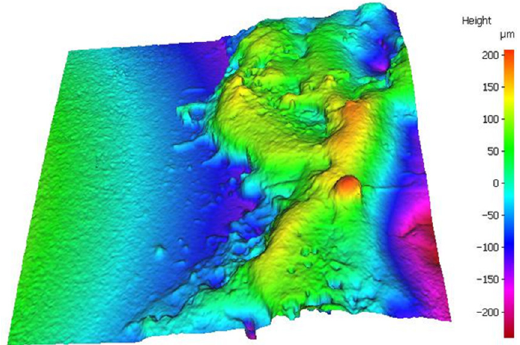
Figure 10. Three-dimensional surface topography of ESD.